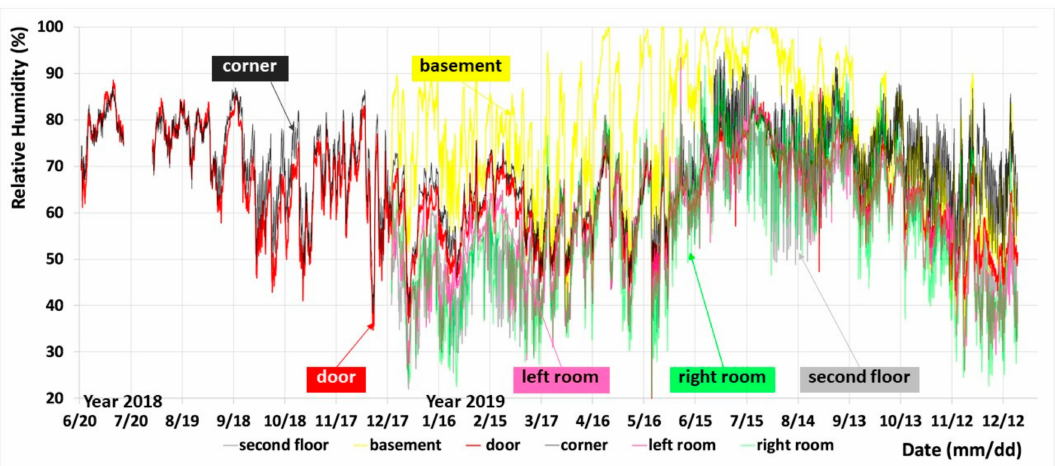
Figure 13. The measured relative humidity values of the o ffi ce